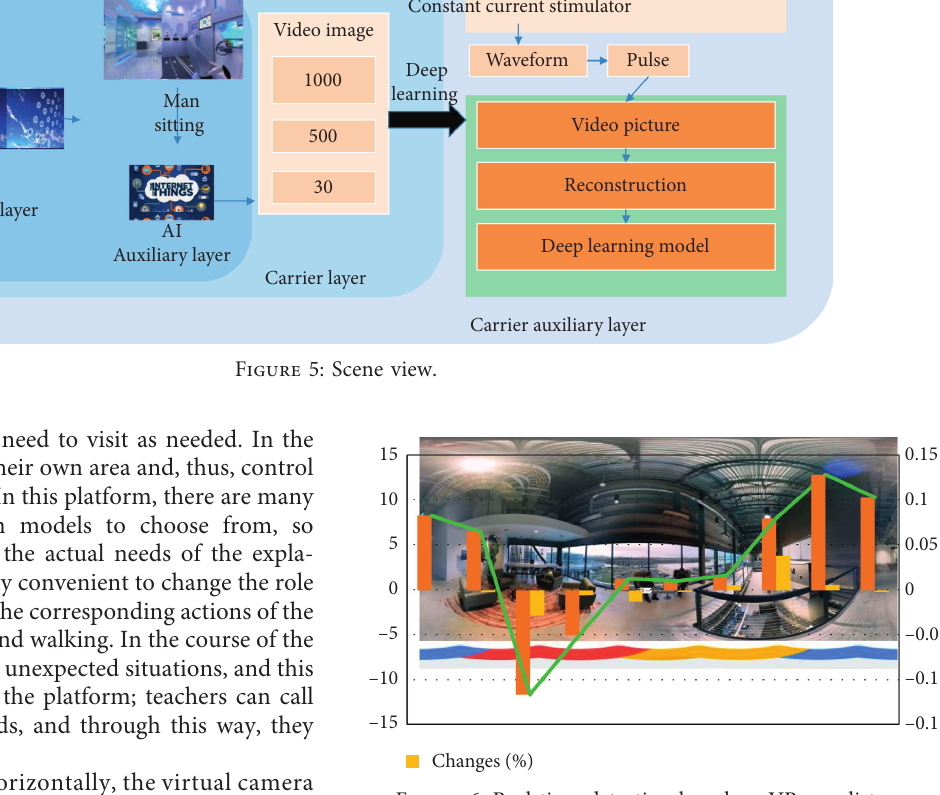
Figure 6: Real-time detection based on VR eye